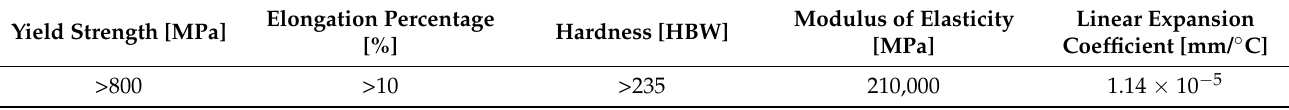
Table 1. Mechanical properties of KR60 rail